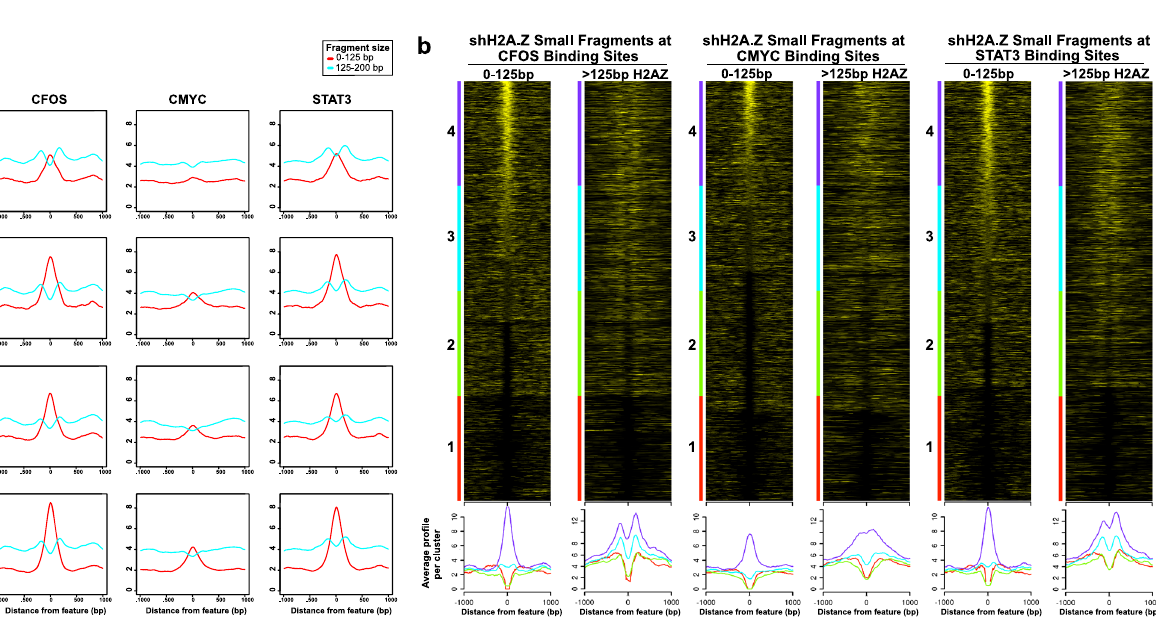
NATURE COMMUNICATIONS| (2021) 12:2524